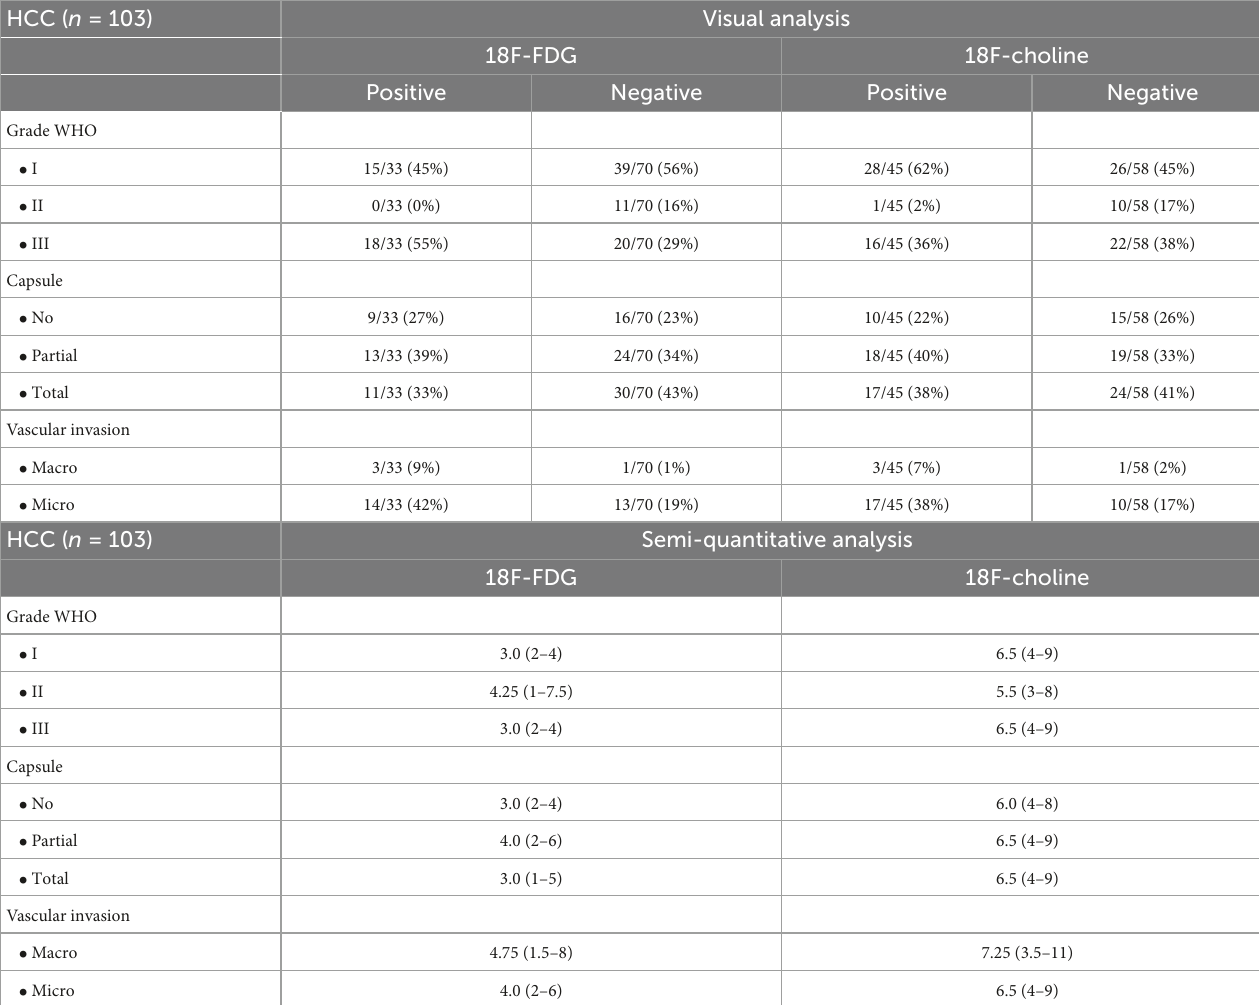
TABLE 2 Positron emission tomography (PET)